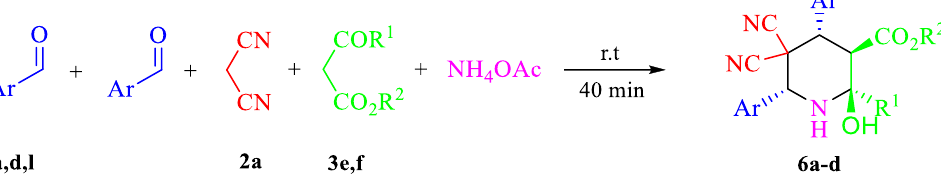
Table 2. Multicomponent synthesis of (2 SR ,3 RS ,4 SR ,6 RS )-2-hydroxypiperidines 6 .